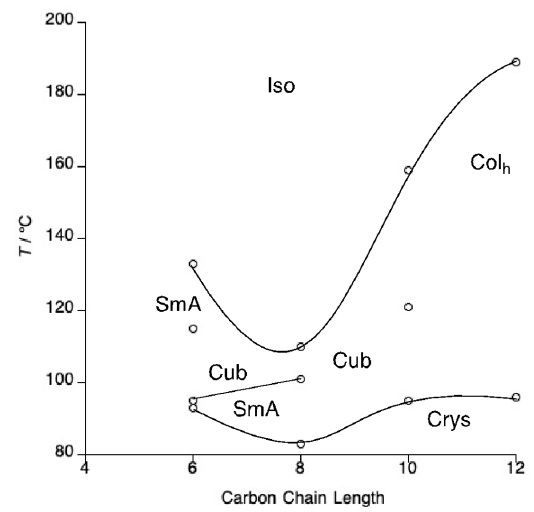
Figure 4. Phase diagram of the tetracatenar N -phenylpyridinium dodecyl-sulfates, 4 - n .